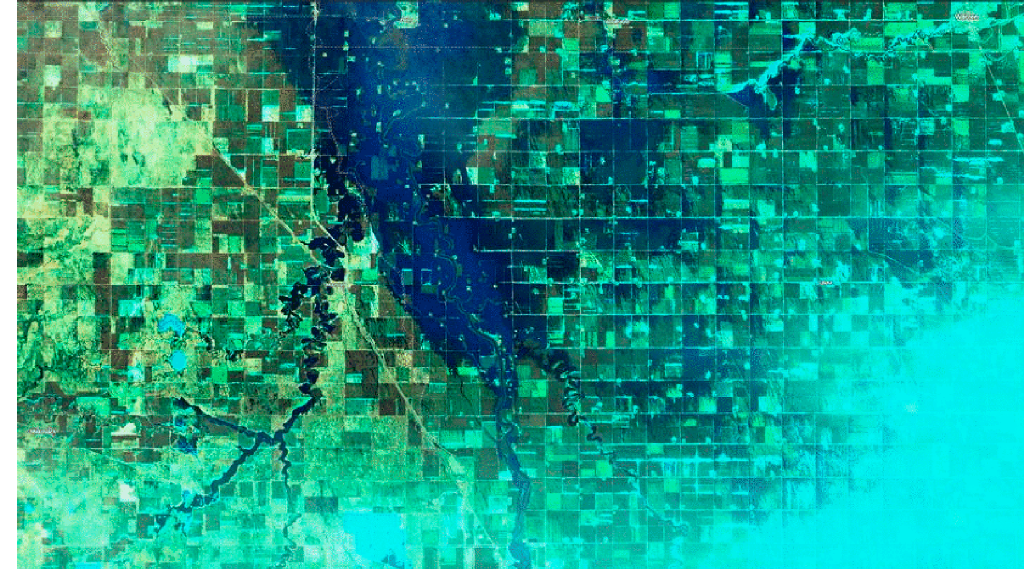
Figure 7. Sentinel-2 Short wave infrared composite (SWIR) imagery on April 10, 2020.